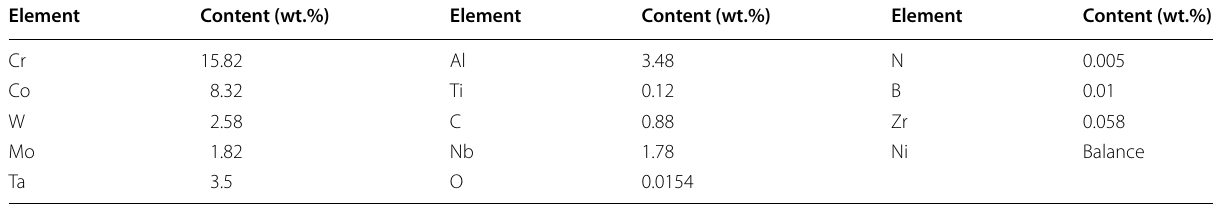
Table 1 Chemical compositions of the Inconel 738LC powders. Element Content (wt.%)